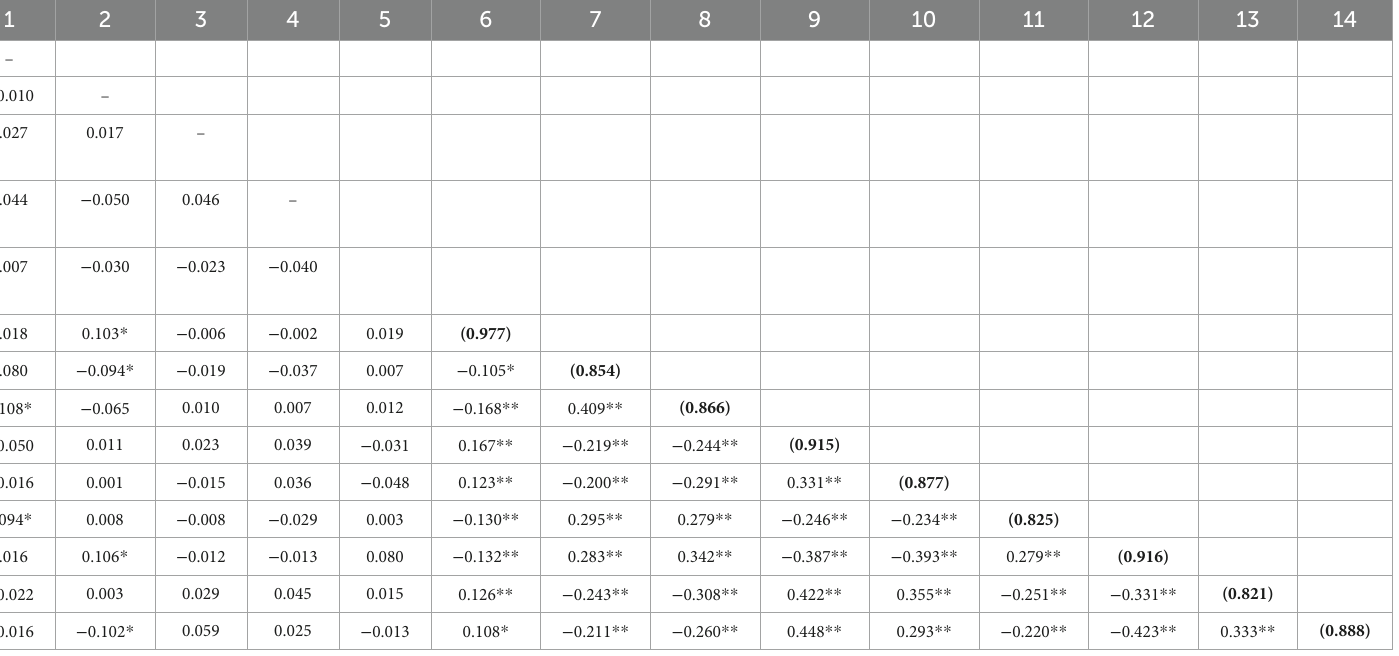
TABLE 2 Means, standard deviations, and